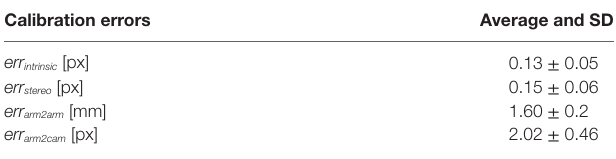
TaBle 3 | Accuracy evaluation: system calibration errors.